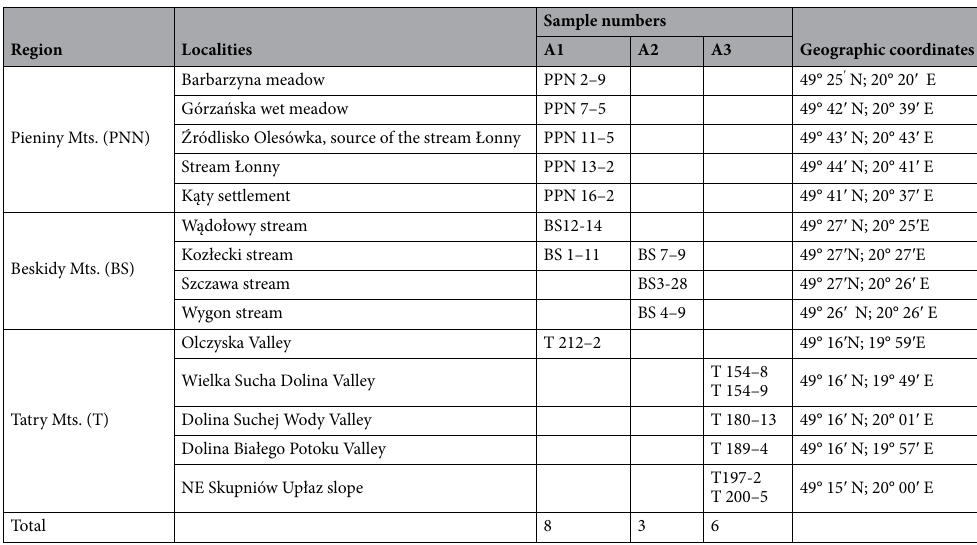
Table 1. Regions, localities and sample numbers of three genetic lineages (A1, A2, A3) within cryptic species of A. pinguis species